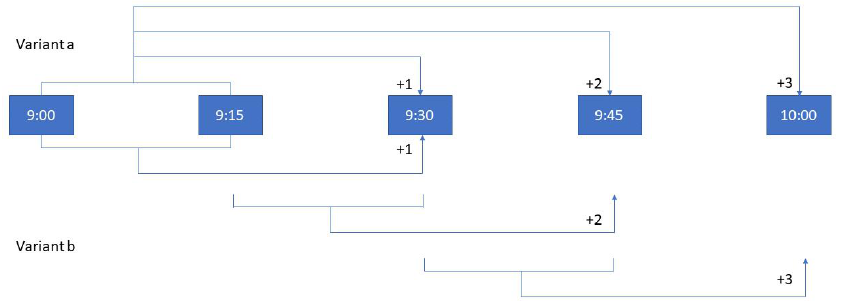
Figure 5. Diagram of two variants of temporal extrapolation during a one-hour time window from 9:00 to 10:00 in the MC-based model.